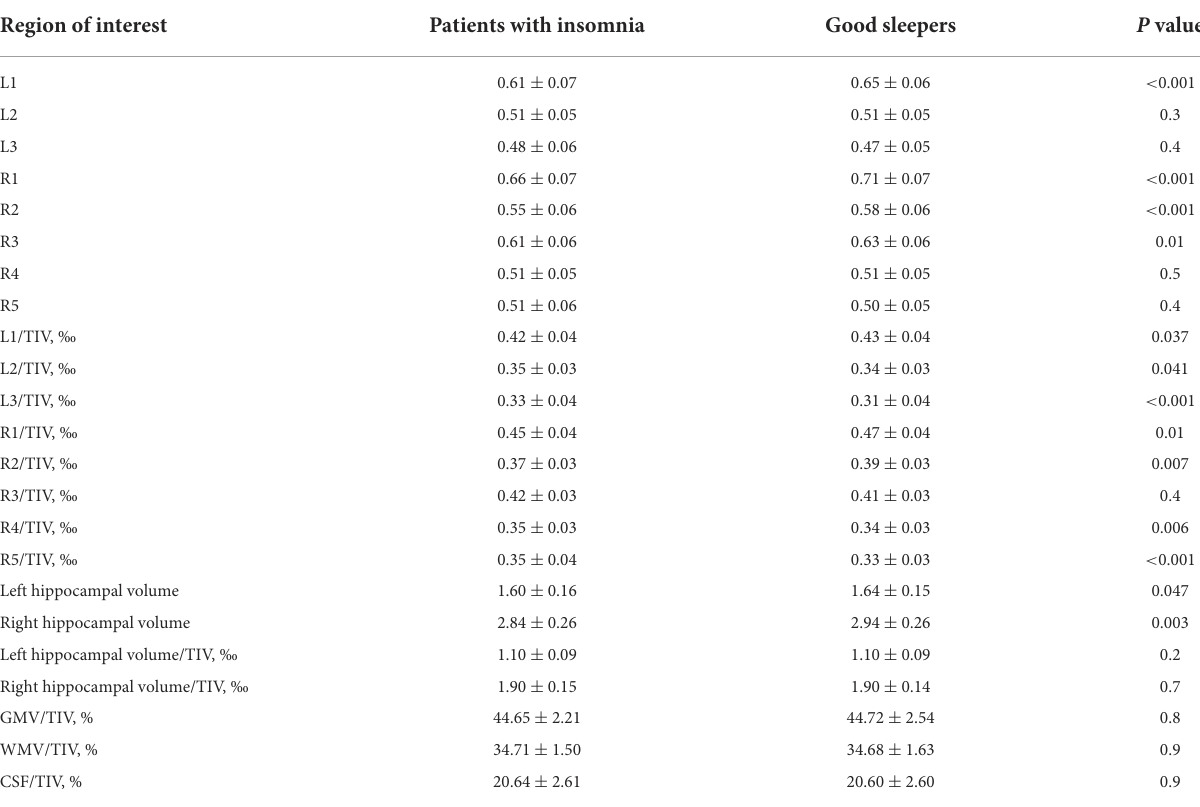
TABLE 2 Altered hippocampal subfield volumes in patients with insomnia and good sleepers. Region of interest Patients with insomnia Good sleepers